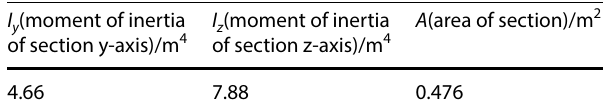
Table 2 The cross-sectional characteristic parameters of the bridge structure